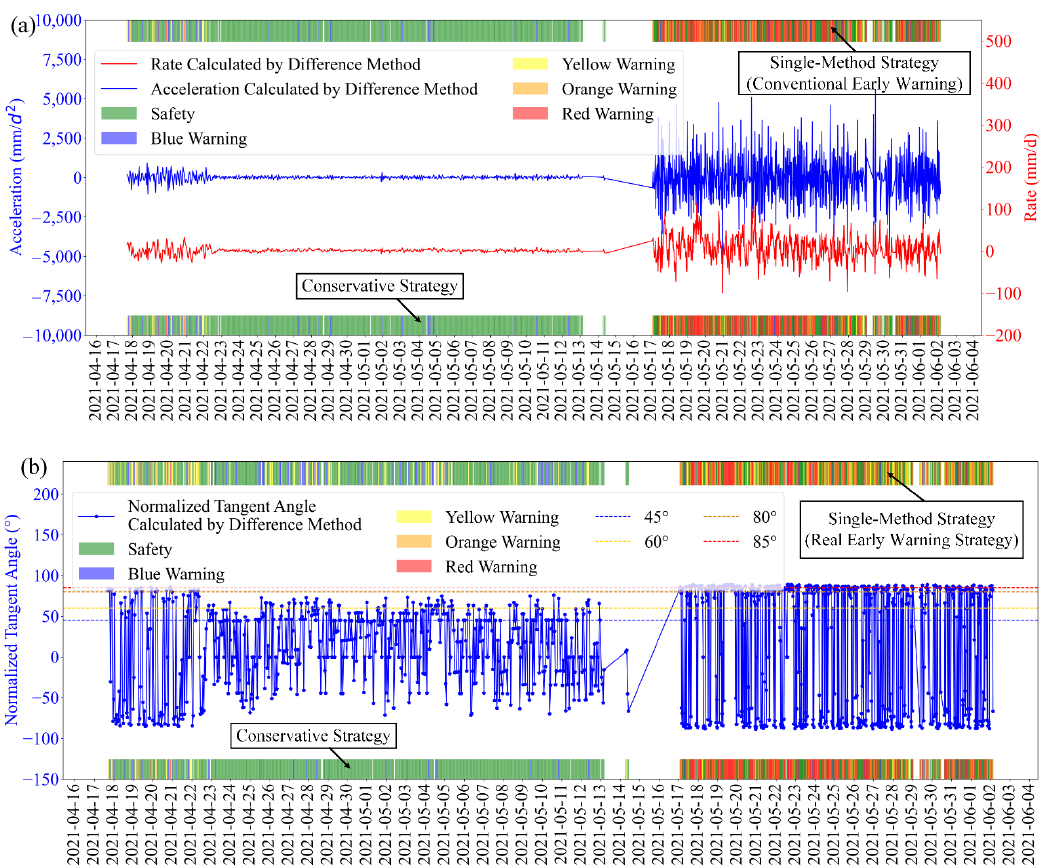
Figure 9. Early warning results of the LISHAN-DB01 monitoring station obtained by the traditional difference method. ( a ) Conventional warning based on velocity and acceleration ( b ) critical sliding warning based on the normalized tangent angle.